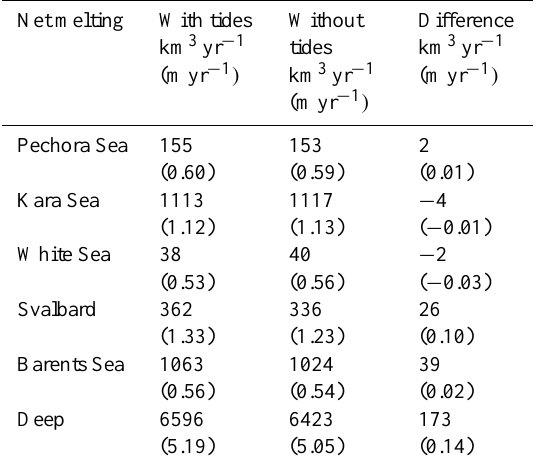
Table 1. Net freezing integrated over the subdomains indicated in Fig. 2b for the model run with tides, the control run without tides and the differences between them (km 3 yr − 1 ) . Also shown in brackets is the ice thickness increase brought about by this amount of net freezing when averaged over each subdomain (myr − 1 ) .